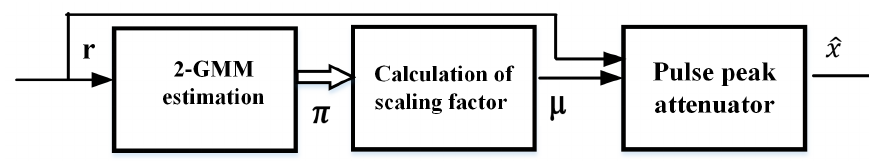
Figure 5. General block diagram for pulse peak attenuator.